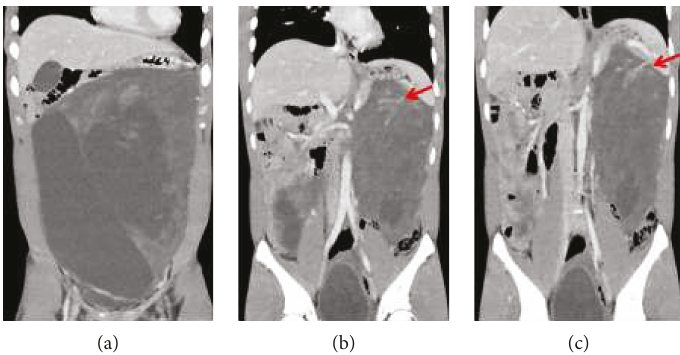
Figure 2: (a – c) CT scan with intravenous contrast (coronal view): the vessel seen from the left gastroepiploic artery to the tumor (red